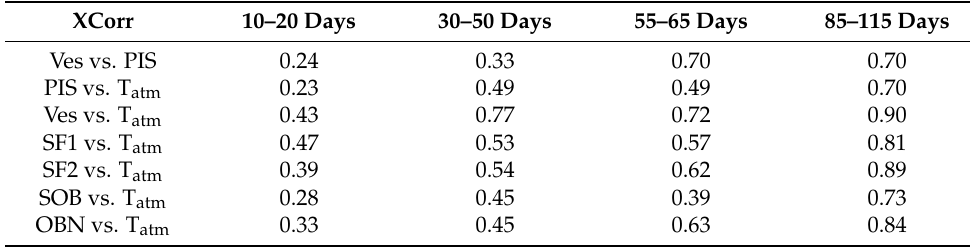
Table 1. Cross-correlation values of time-series.